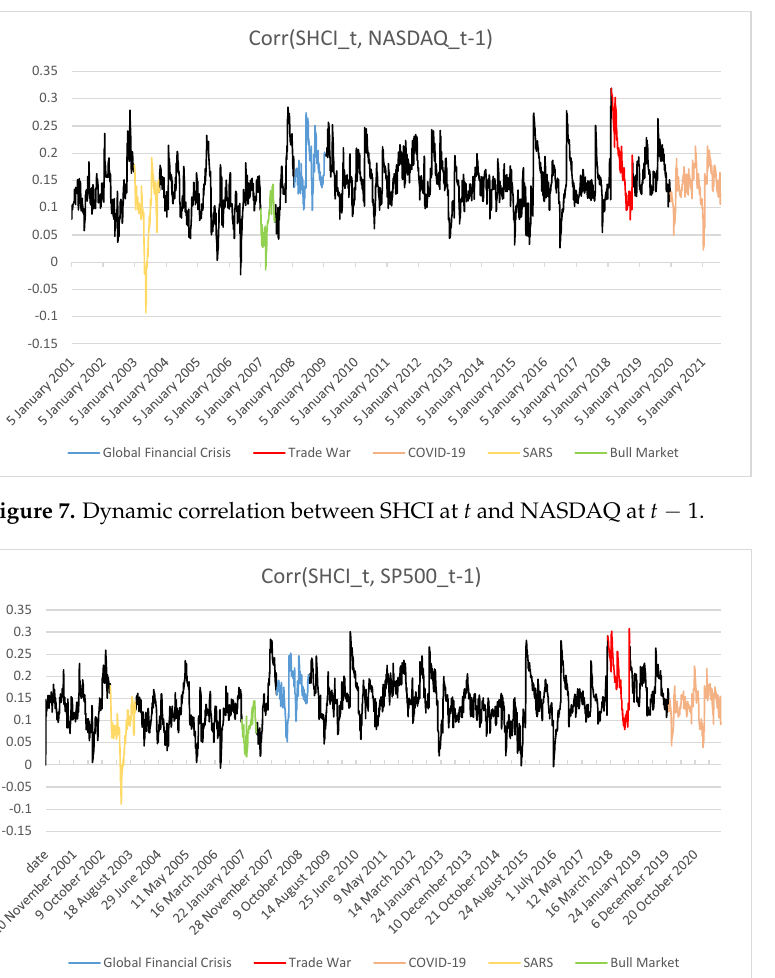
Figure 6. Dynamic correlation between SHCI and USD.